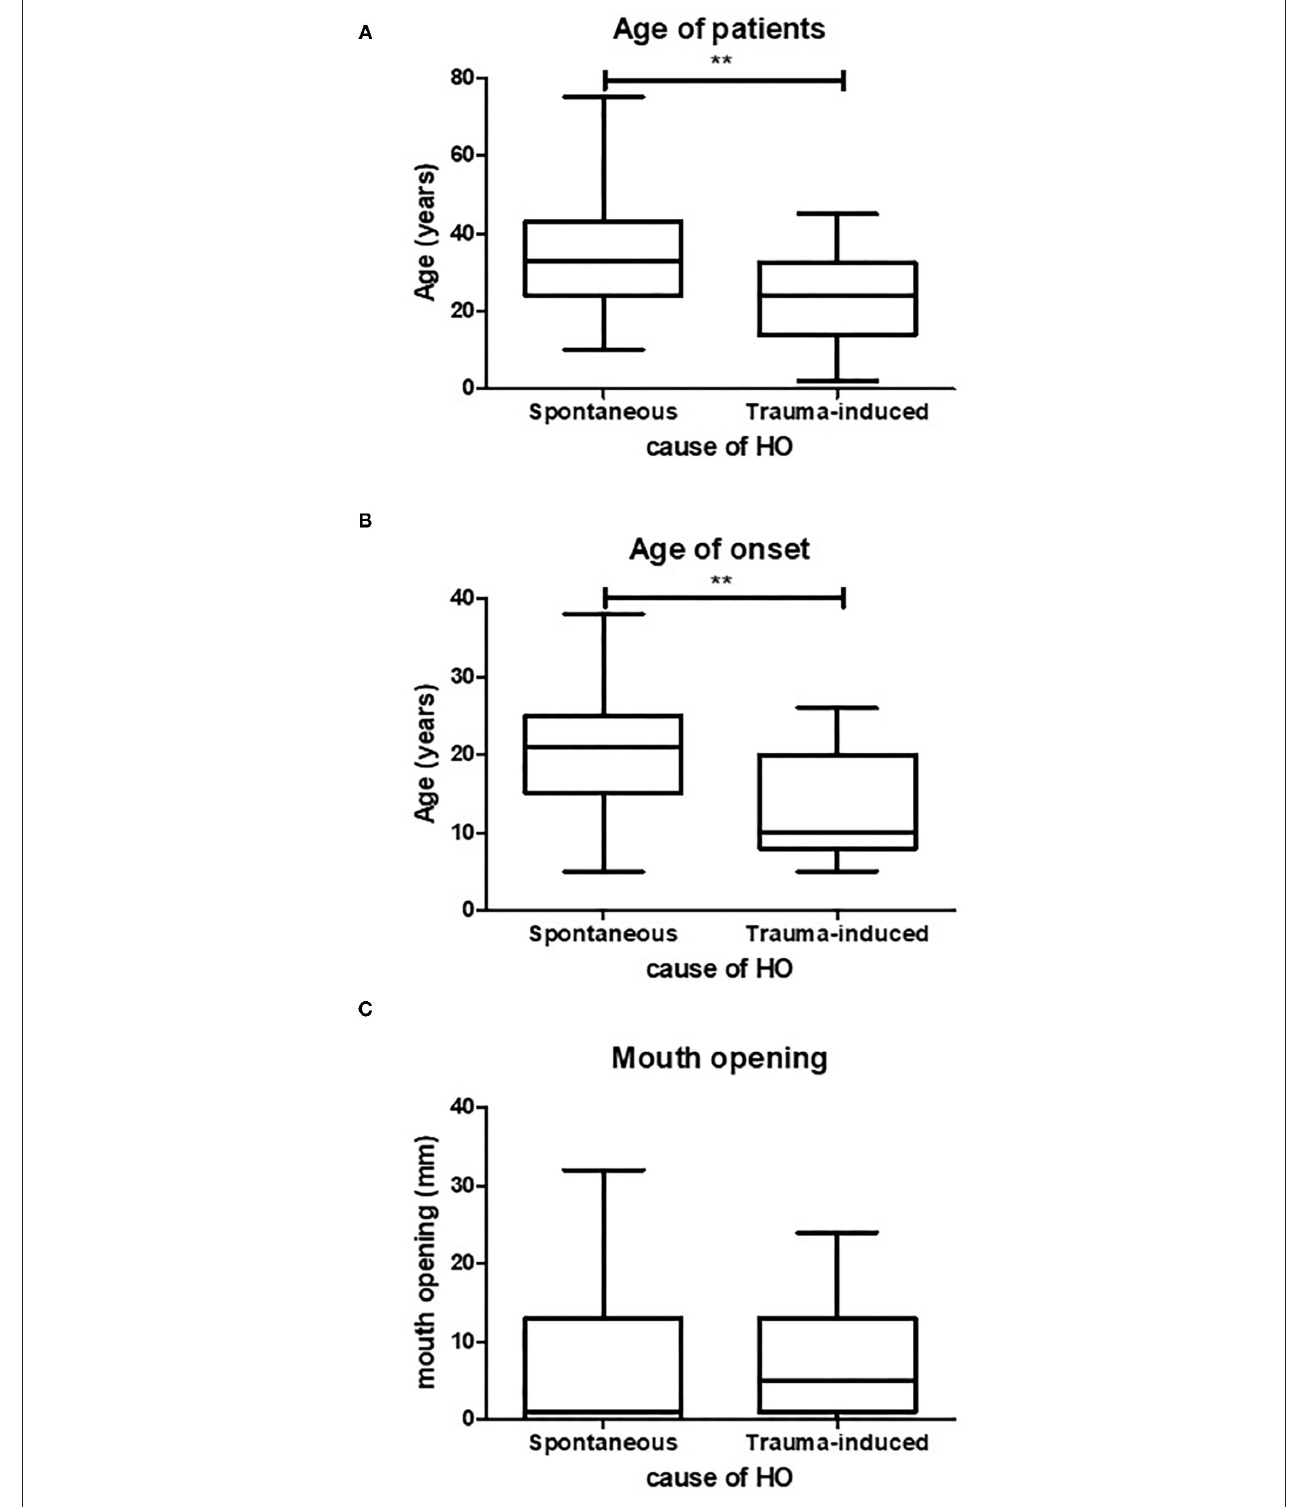
FIGURE 3 | Age of spontaneous or trauma-induced HO. Trauma-induced HO occurs at a significantly lower age compared to spontaneously occurring HO, (A) ( p < 0.05, spontaneous n = 47, trauma induced n = 22). Also the mean age of onset is significantly lower in trauma-induced HO, (B) ( p < 0.05, spontaneous n = 41, trauma induced n = 17). There is no difference in maximum mouth opening between the two causes of HO (C) (spontaneous n = 27, trauma induced n = 11). ** p < 0.01.